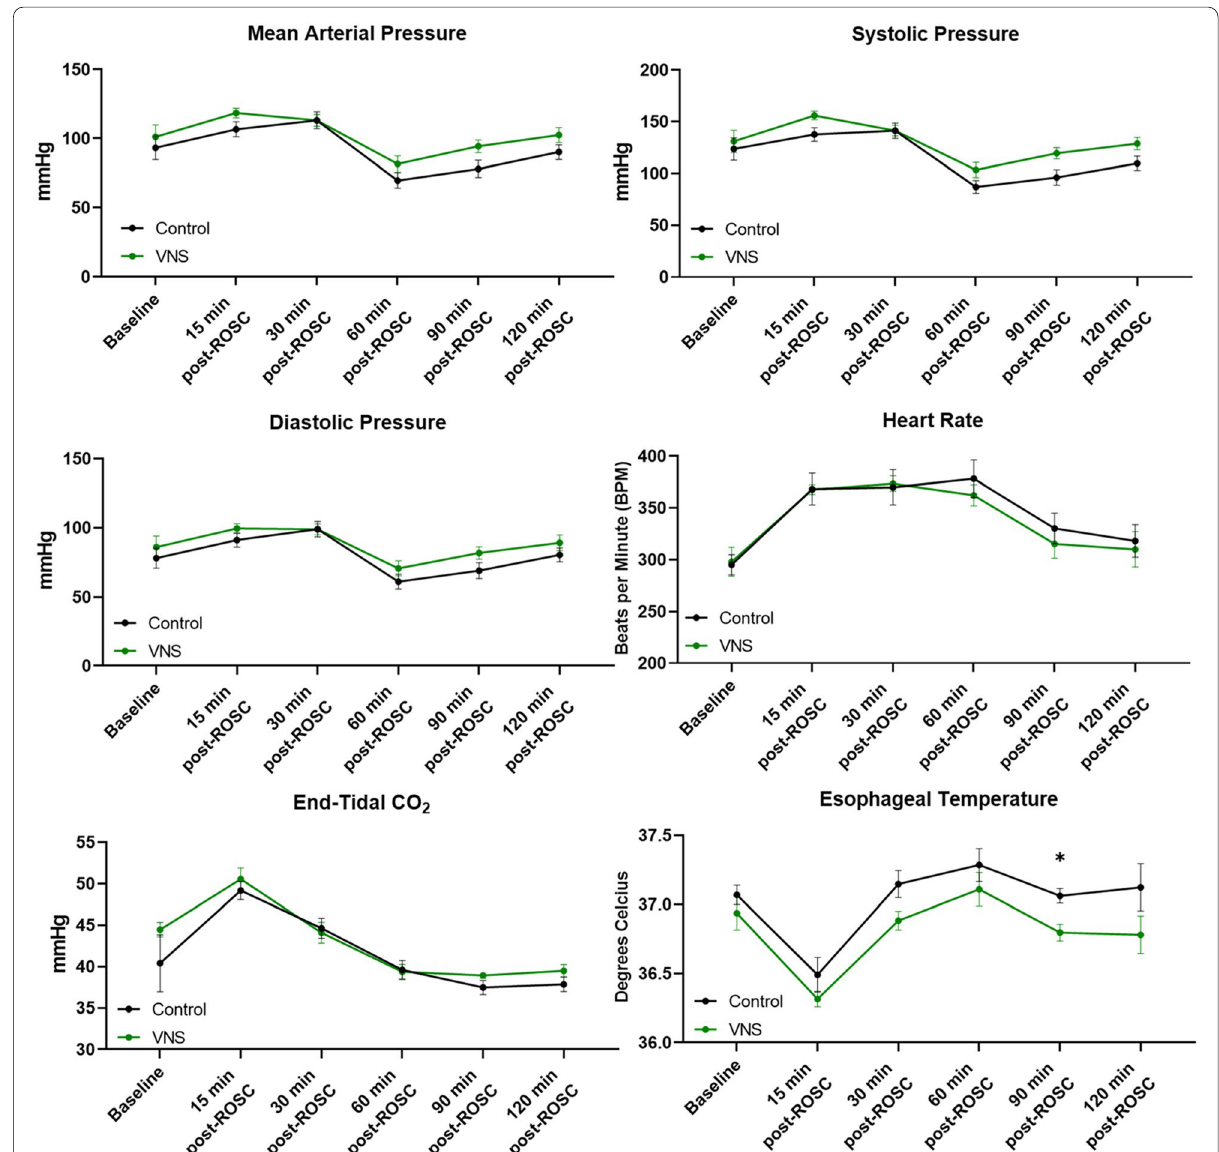
Fig. 2 Hemodynamics characteristics. No significant difference was observed between groups. N RM two-way ANOVA with Šídák’s multiple comparisons test for between groups. Only difference between groups was observed in